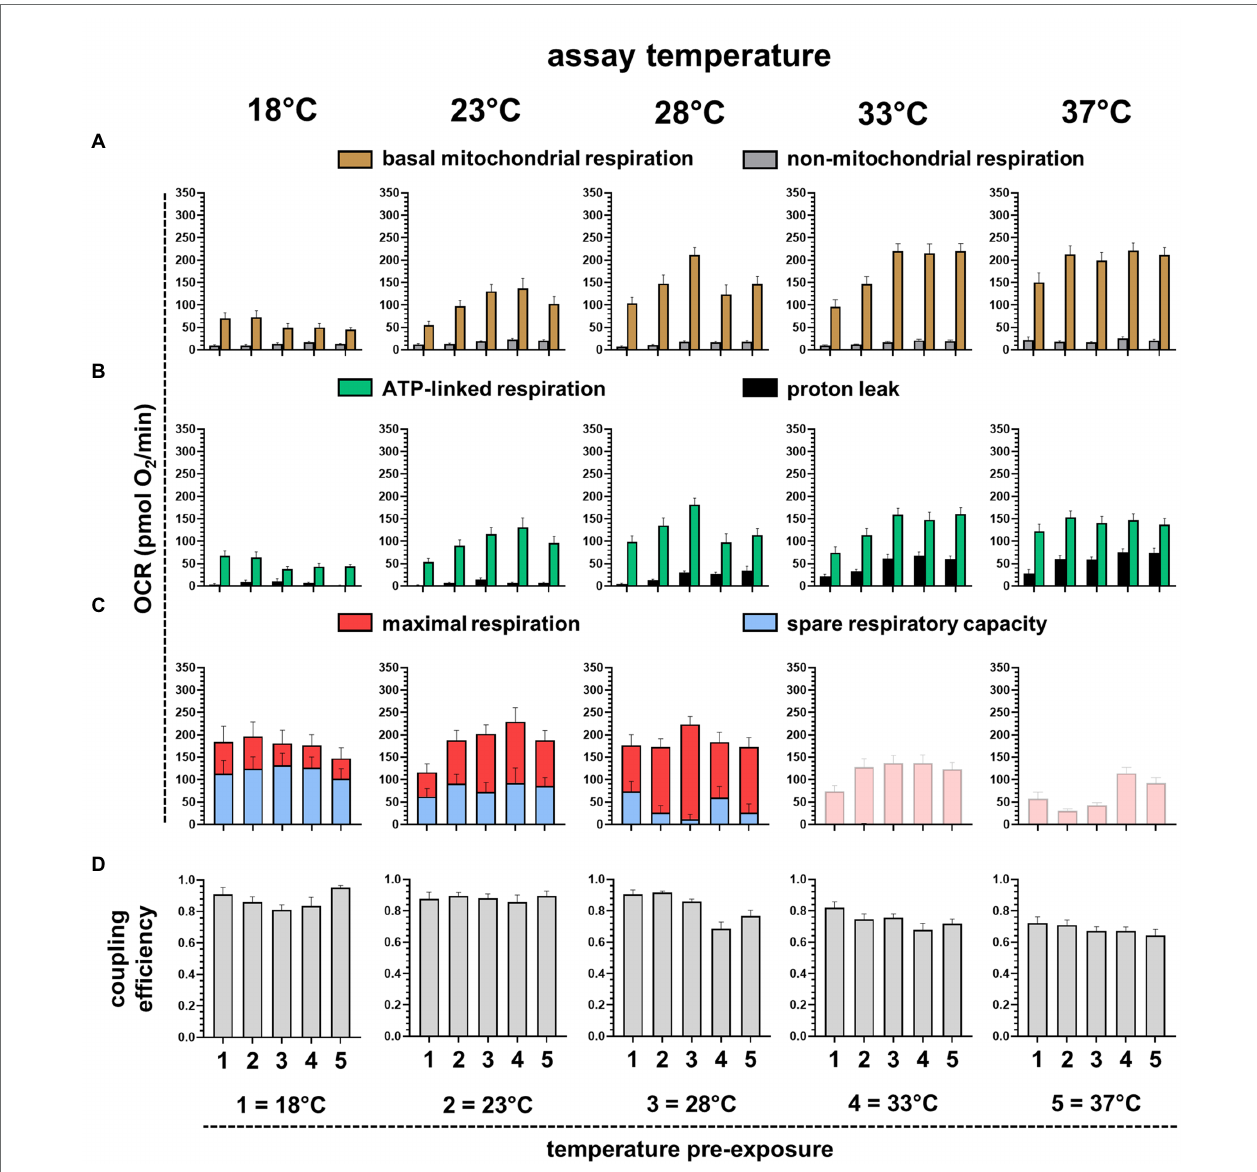
FIGURE 5 | Analysis of different respiratory parameters of embryos pre-exposed to different temperatures and measured at different assay temperatures. (A) Mitochondrial (brown) and non-mitochondrial (gray) respiration determined with rotenone and antimycin A. (B) ATP-linked (green) and proton leak (black) respiration determined using oligomycin. (C) Maximal respiration (red) induced with FCCP and spare respiratory capacity (blue), determined by subtracting basal respiration. At 33 ° C and 37 ° C, FCCP did not induce respiration above basal respiration and thus, could not be further analyzed. (D) Coupling efficiency (CE) calculated as fraction of respiration dedicated to ATP synthesis (ATP-linked respiration) of basal mitochondrial respiration. Averaged values represent 16–32